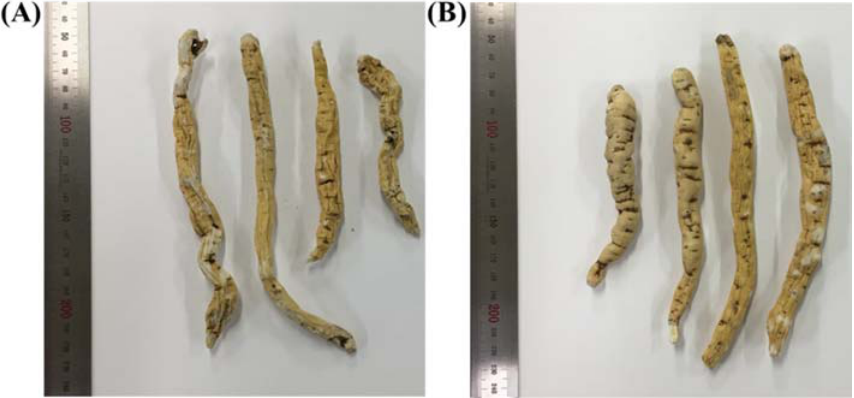
Figure 1. Commercial dried samples of Cynanchum wilfordii Radix ( A ) and Cynanchum auriculatum Radix ( B ).